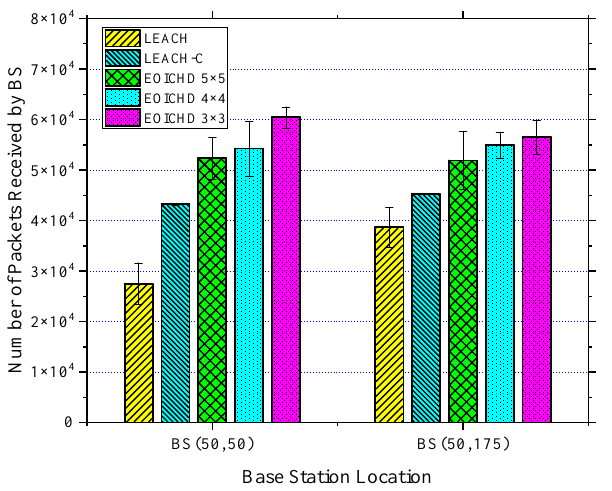
Figure 11. Average data packets received at the Base Station (BS) for Scenario #1 and Scenario